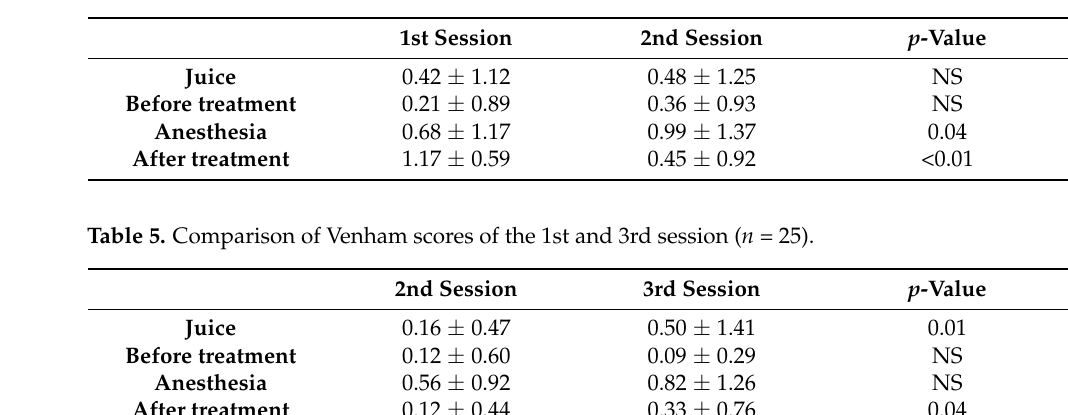
Table 4. Comparison of Venham scores in 1st and 2nd session ( n = 103).